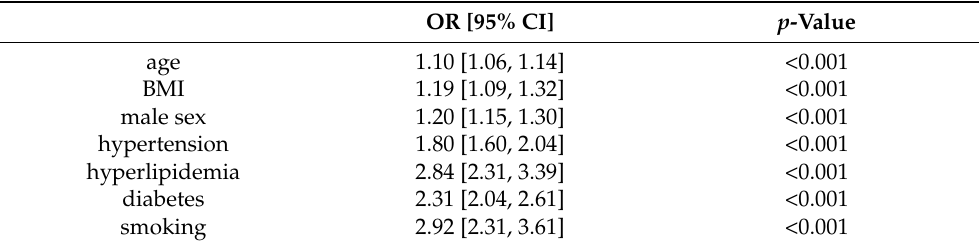
Table 2. Odds ratio of different risk factors adjusted for age, sex, hyperlipidemia, diabetes, arterial hypertension, and smoking for a PAT above 250 mL in a multivariate